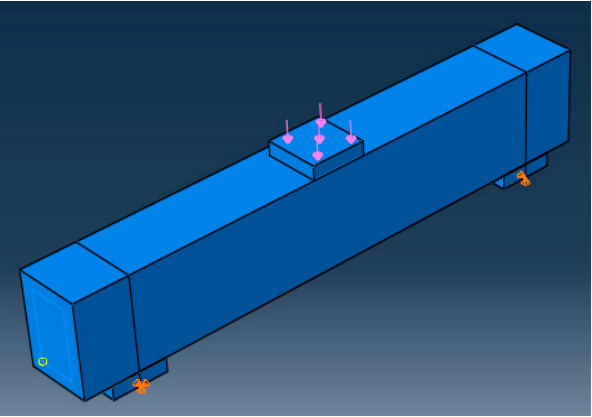
Figure 9. Loading and boundary conditions.